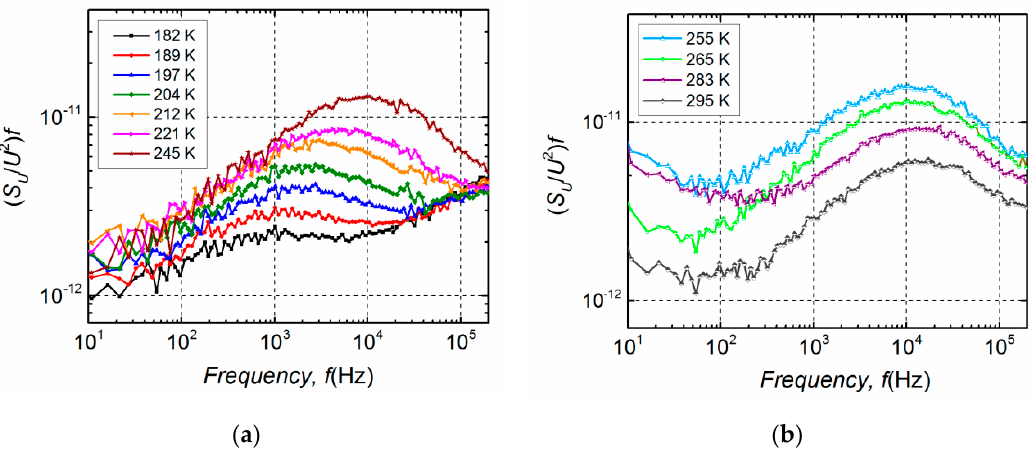
Figure 11. Normalized g-r noise spectra ( S U / U 2 ) f of the investigated group A LD at different temperatures at forward current I = 30 mA: in the temperature range from 182 K to 245 K ( a ) and from 255 K to the room temperature 295 K ( b ).